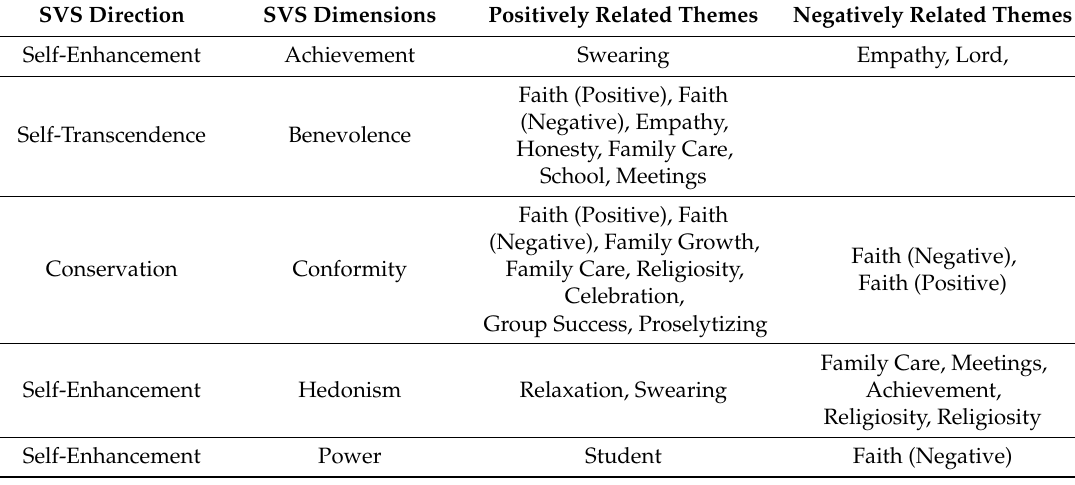
Table 1. Schwartz Value Survey (SVS)-related